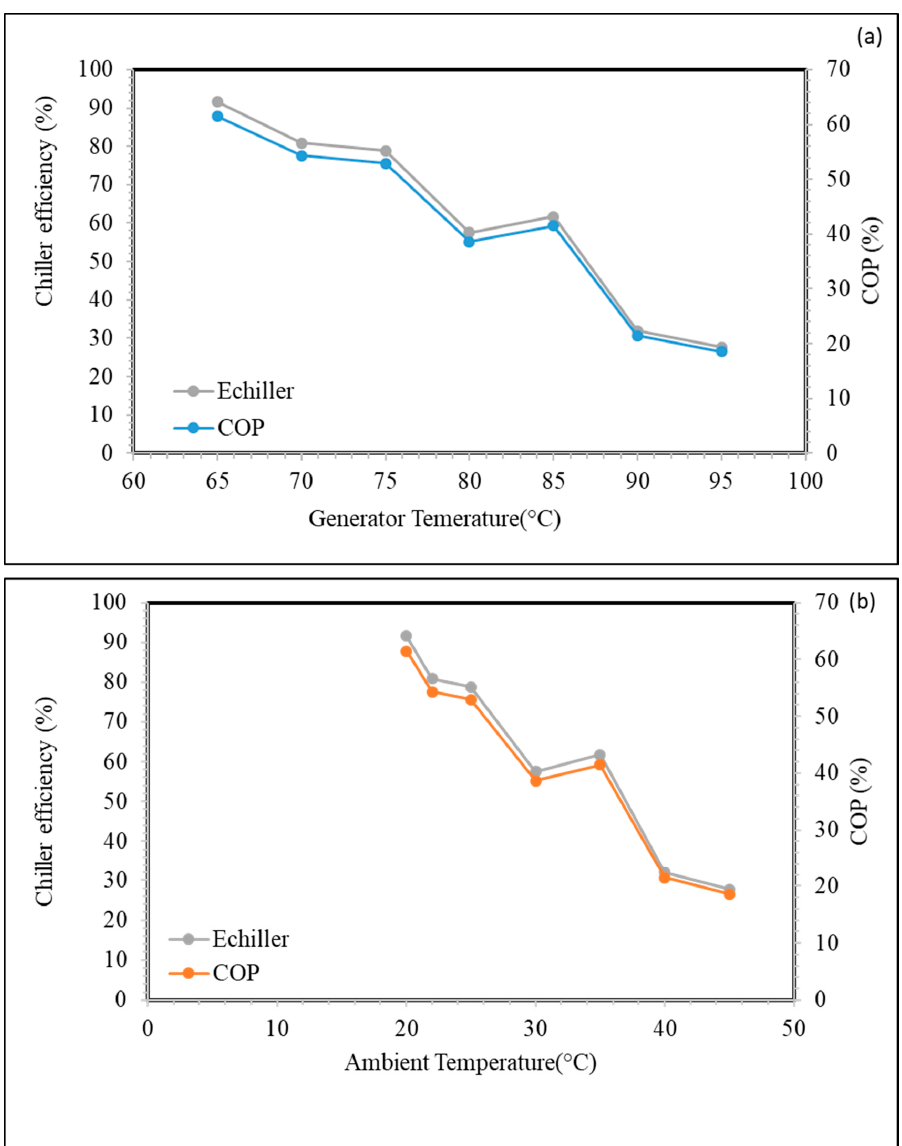
Figure 4. Evolution of the absorption chiller’s efficiency (E chiller ) and the coefficient of performance (COP) of the cooling process as a function of ( a ) Generator inlet temperature, and ( b ) Ambient .